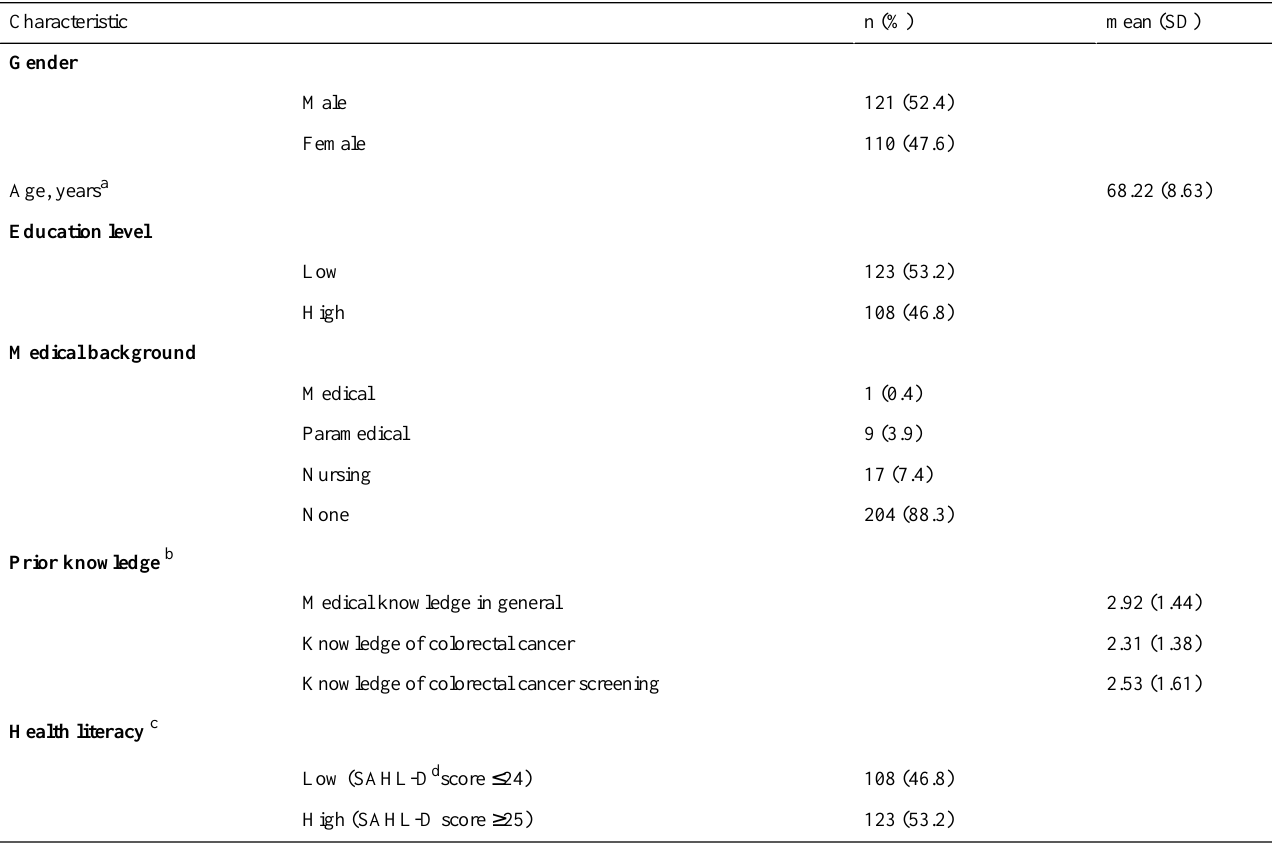
Table 1. Overview of participant background characteristics